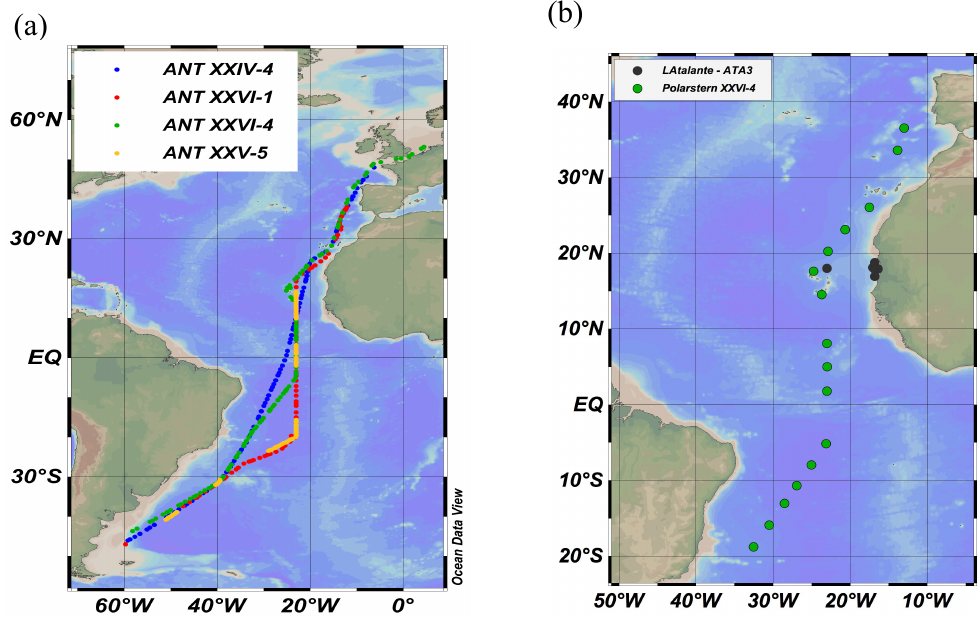
Figure 1. (a) cruise tracks of the RV Polarstern , dots indicate positions of discrete atmospheric air sampling, (b) positions of surface water headspace sampling during ANT-XXVI/4 ( n = 16, green dots) and the RV L’Atalante ATA-3 cruise ( n = 6, black dots). Table 1. Overview of sample distribution during the cruises: type A are discrete atmospheric samples, type H are headspace samples extracted from the surface water. The sample numbers in brackets give the number of measured samples in the Northern Hemisphere (NH) and Southern Hemisphere